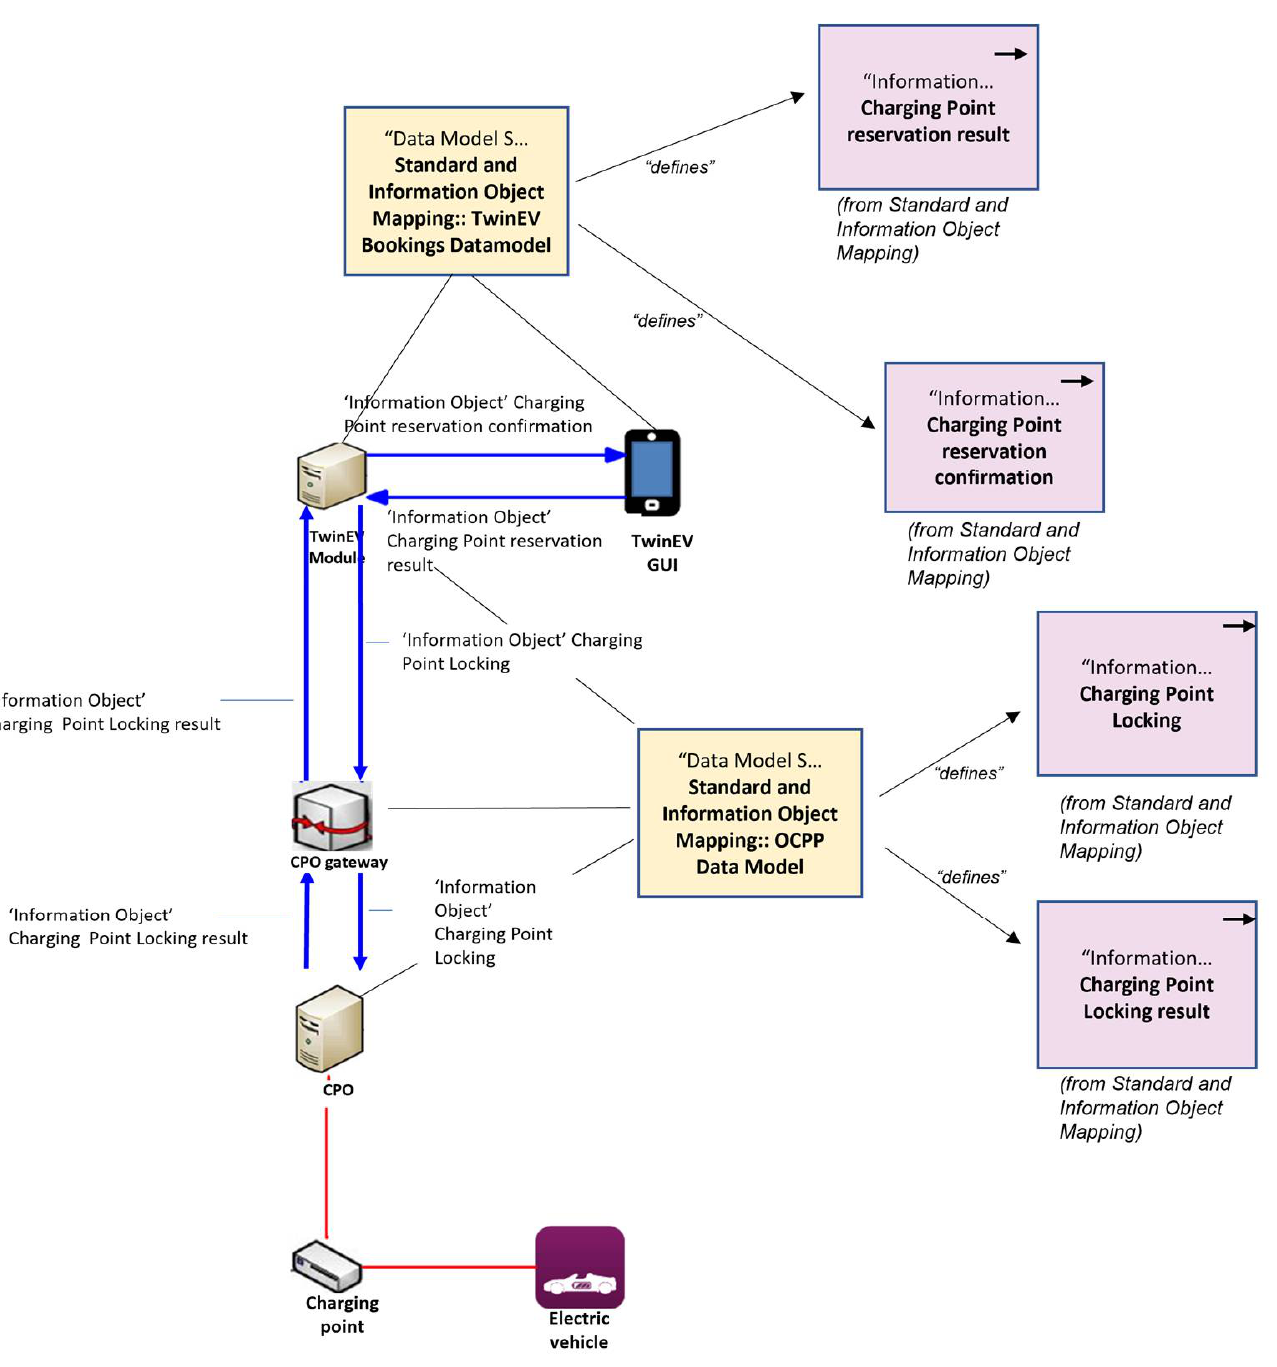
Figure 6. SGAM Standards and Information Object Mapping in the PUC scenario.